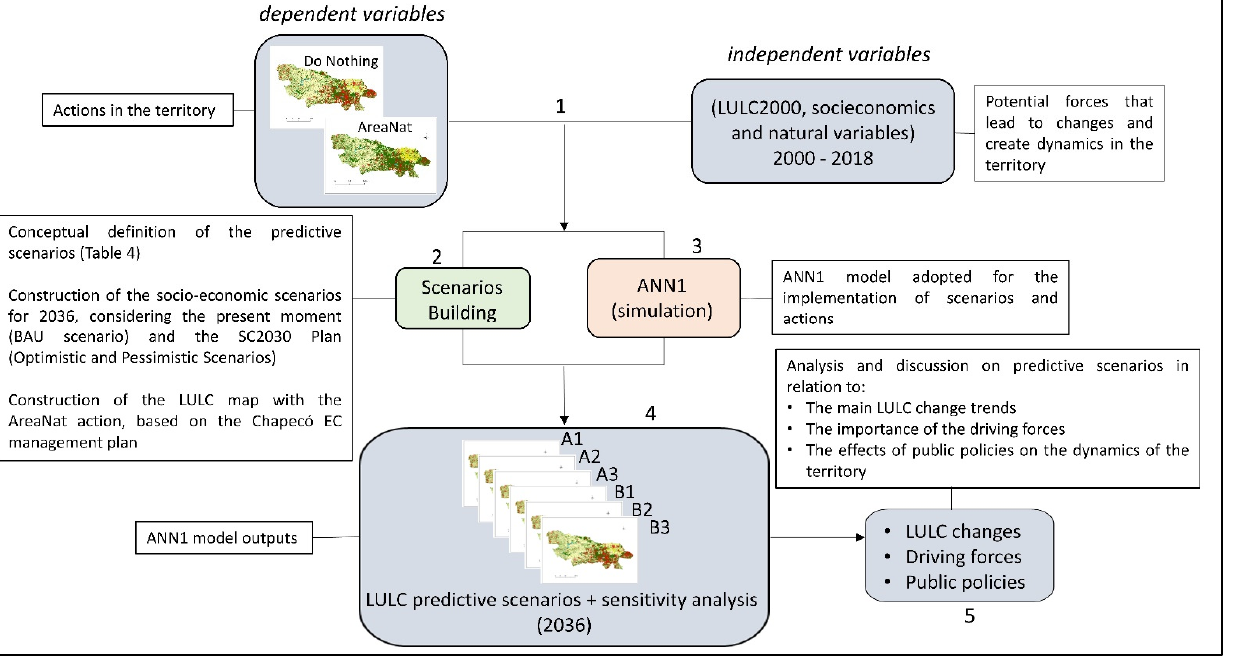
Figure 3. Methodological framework. Step 1—variable selection and systematisation; Step 2—pre- Methodological